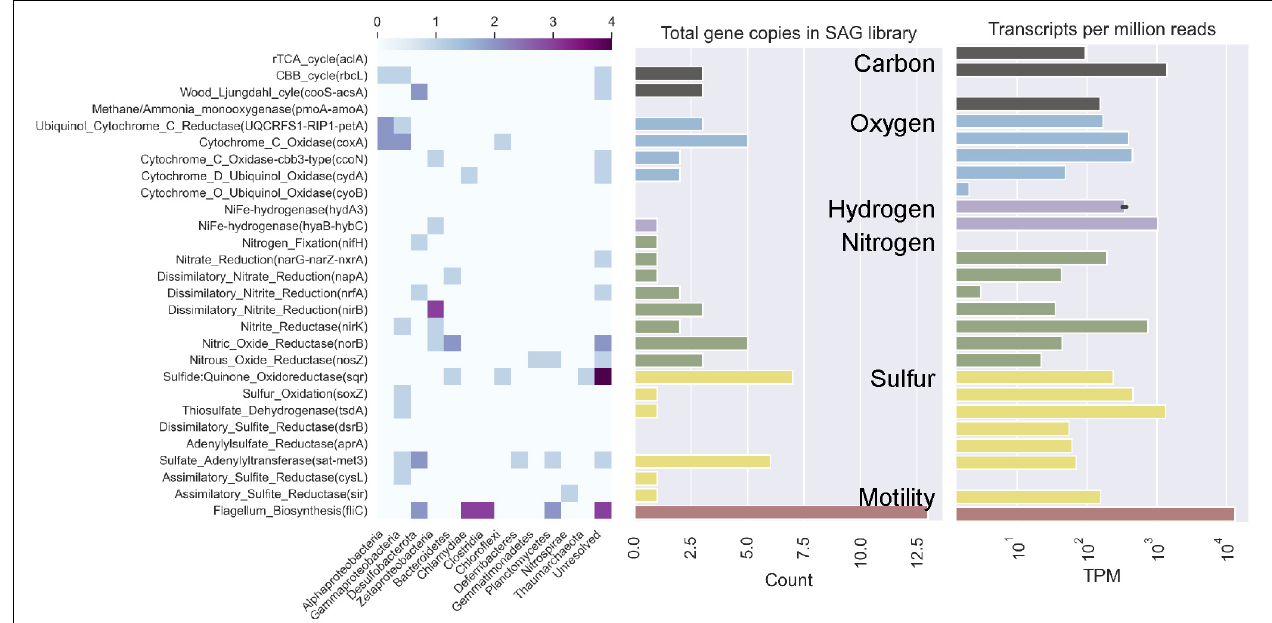
FIGURE 5 | Comparison of functional potential of Hole U1383C Deep microbial community based on single cell amplified genomes (SAGs, this study) versus metatranscriptomic interpretation (from Seyler et al., 2020). Abundance of key genes for carbon, oxygen, hydrogen, nitrogen, and sulfur metabolisms and flagellum biosynthesis are shown on y-axis, in same order as presented in Seyler et al. (2020). In left panel, relative abundance of these genes in SAGs of various taxonomic groups are shown according to the heat map above. In the center panel, the total copies of these key genes in the entire low-coverage SAG dataset is shown for comparison to the metatranscriptomic observation shown in the right panel (as transcripts per million reads on a log scale, as reported in Seyler et al.,